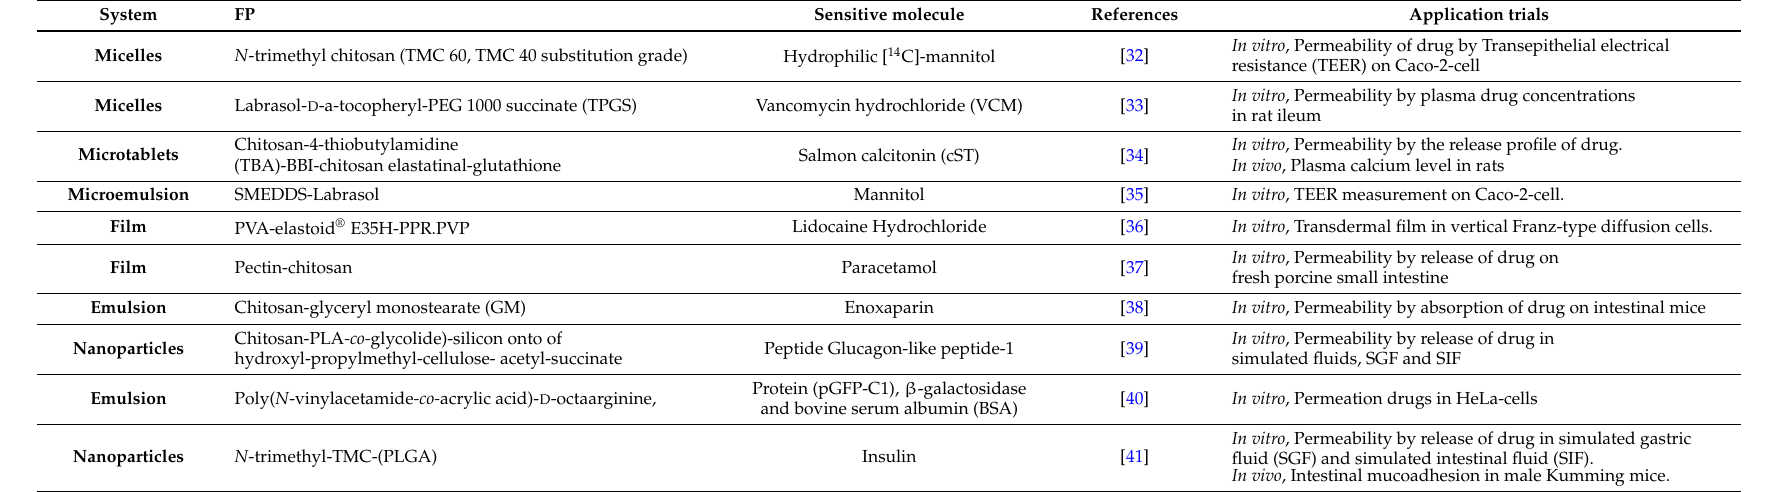
Table 1. FP systems with permeability enhancement on sensitive molecules.